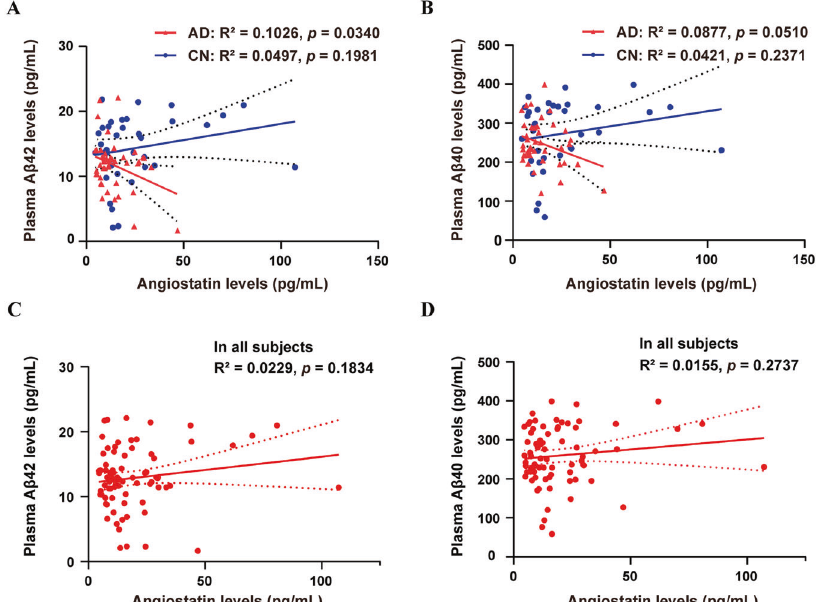
Fig. 2 Correlation analyses of plasma angiostatin with plasma A β levels. Correlations of angiostatin levels with plasma A β 42 levels ( A ) and A β 40 levels ( B ) in PiB-PET + AD dementia patients and cognitively normal controls (CN). Correlations of angiostatin levels with plasma A β 42 levels ( C ) and A β 40 levels ( D ) in all